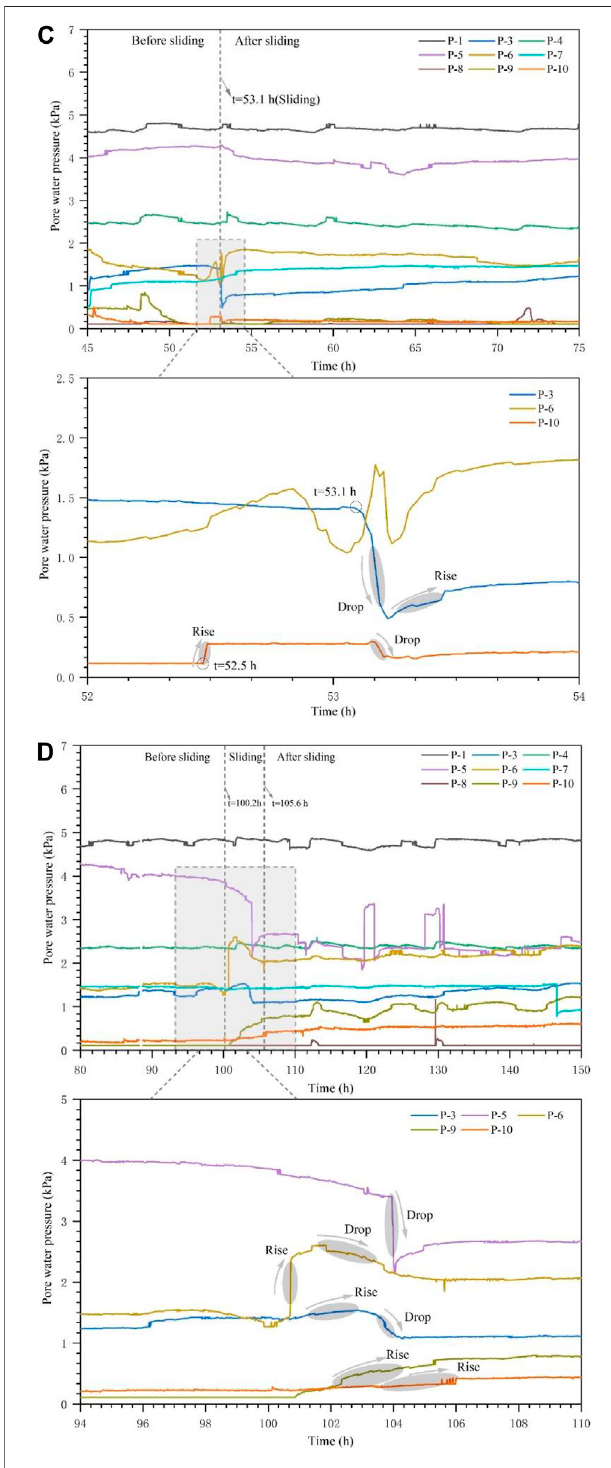
the reduction in the seepage path length of the rear dam during sliding. In the second slide stage, the pore water pressure is maintained at a low level until it surges to a higher level after the